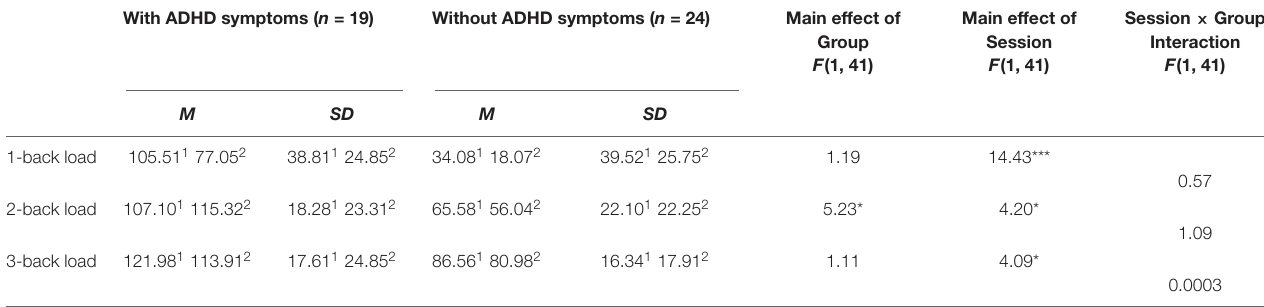
TABLE 5 | N-back total error scores at each session. With ADHD symptoms ( n = 19) Without ADHD symptoms ( n =